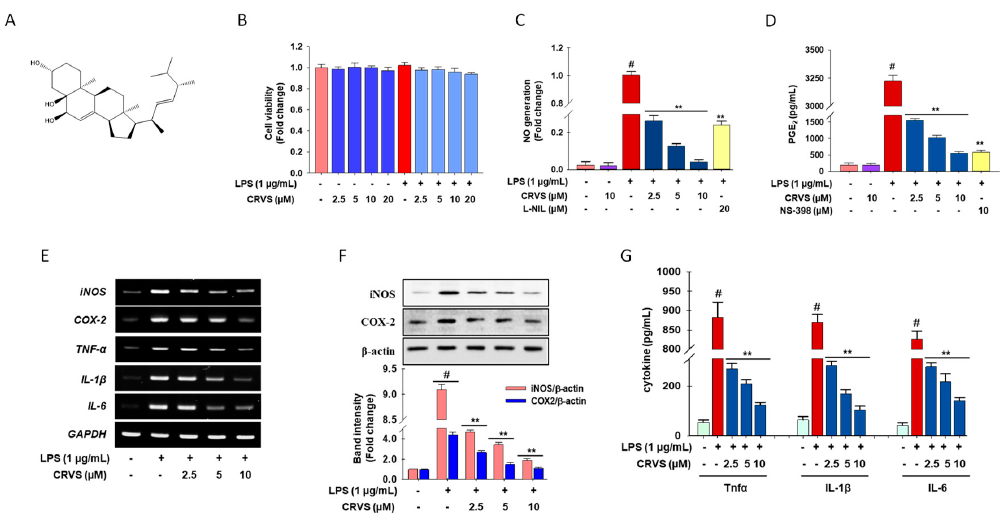
Figure 1. Anti-inflammatory effects of cerevisterol (CRVS). The chemical structure of CRVS ( A ). Cells (1 × 10 5 cells/mL) were seeded in a 96-well plate and incubated for 24 h. Then the cells were treated with indicated concentrations of CRVS (2.5–20 μ M) or vehicle alone for 20 h and/or for 3 h, followed by LPS (1 μ g/mL) and incubated for 24 h. Effect of CRVS on cell viability ( B ), nitric oxide (NO) production ( C ), prostaglandin E 2 (PGE 2 ) ( D ), and mRNA expression of inducible nitric oxide synthase (iNOS), cyclooxygenase-2 (COX-2), tumor necrosis factor- α (TNF- α ), interleukin-1 β (IL-1 β ), and interleukin-6 (IL-6) ( E ); protein expression of iNOS and COX-2 ( F ) and the cellular expression of TNF- α , IL-1 β , and IL-6 in LPS-induced RAW 264.7 macrophages ( G ). # p < 0.05 as compared with the vehicle-treated control; ** p < 0.05 as compared with LPS